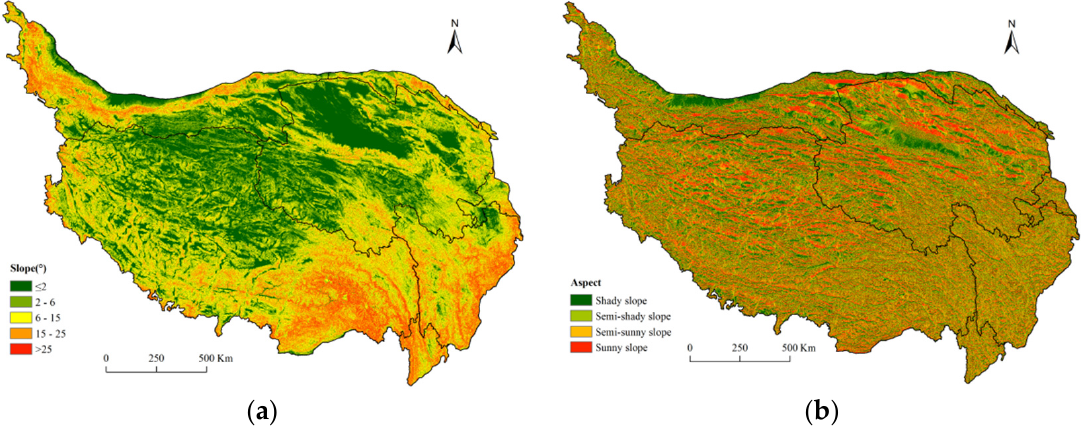
Figure 2. Slope ( a ) and aspect ( b ) on the Qinghai–Tibet Plateau.